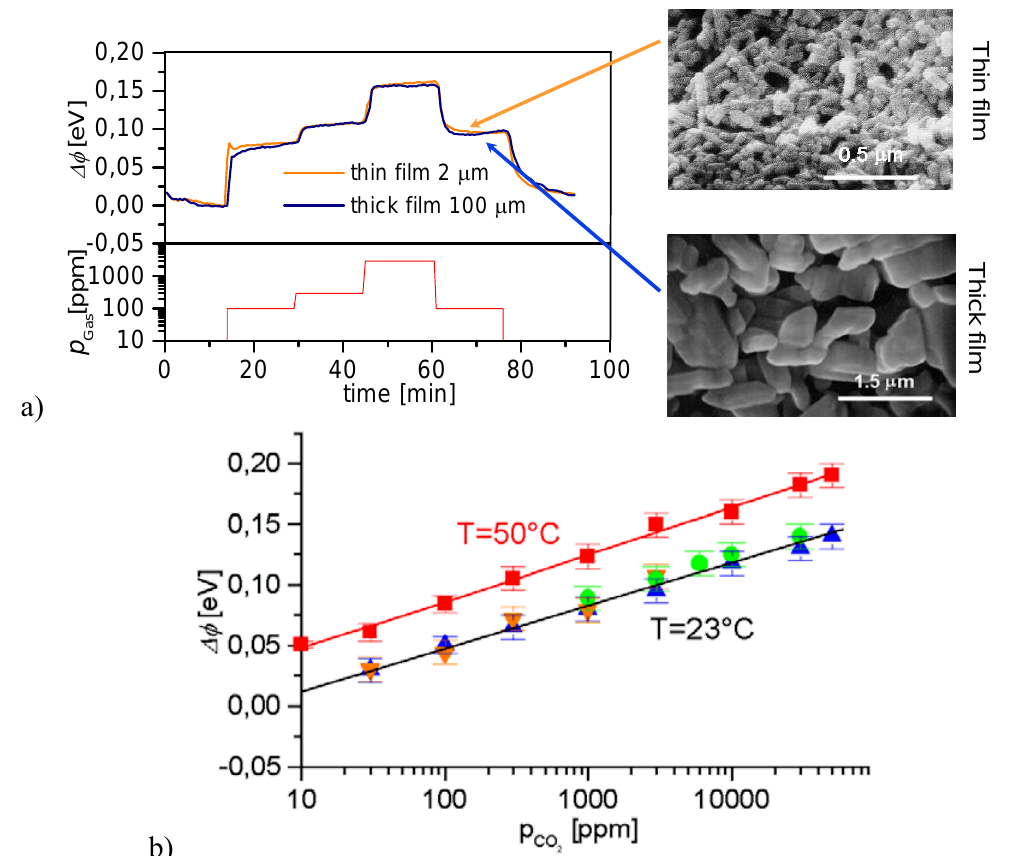
Figure 19. Detection of CO 2 with the BaCO 3 system: (a) Work function change of two at room temperature in response to CO different preparations of BaCO 3 detection in wet synthetic air. Reprinted from [163] with characteristics for CO 2 permission from